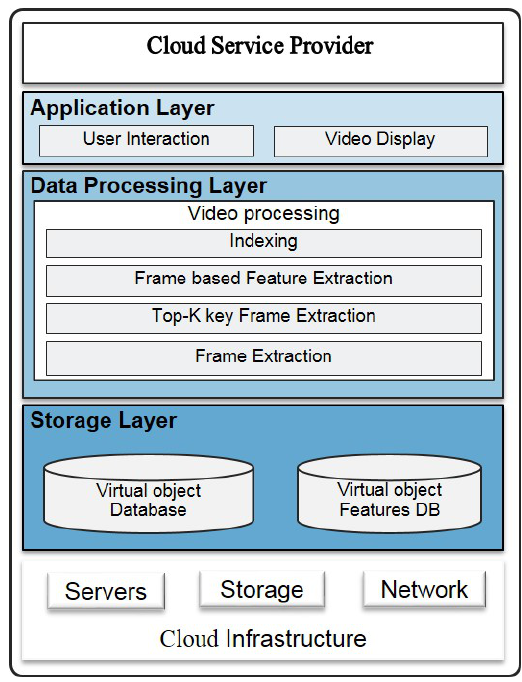
Figure 1. System architecture for the proposed